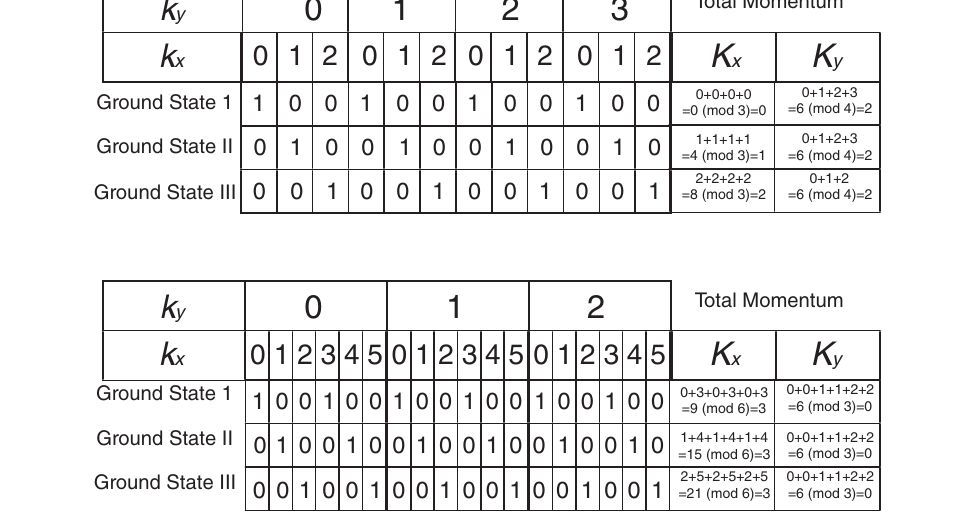
FIG. 10. Example of the total momentum counting for the 3-fold degenerate ground states of the N ¼ 4 (top) and N ¼ 6 (bottom) problem. Every time the number of particles N is a multiple of both k x ; k y , the 3-fold degenerate ground states occur at the same total momentum and are expected to be split by the interaction for finite-size samples. Notice that for the N ¼ 4 problem, the total momenta at which the ground state occurs are related by inversion symmetry, as ð 1 ; 2 Þ ¼ ð(cid:2) 2 ; (cid:2) 2 Þ mod ð 3 ; 4 Þ